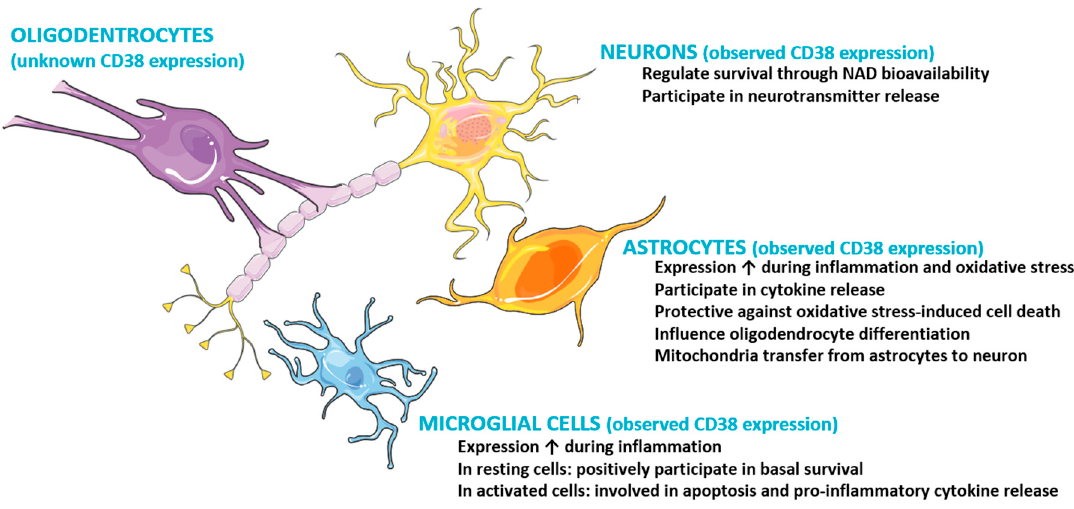
Figure 1. Cartoon summarizing current data on CD38 expression and functions in neuronal and glial cells.